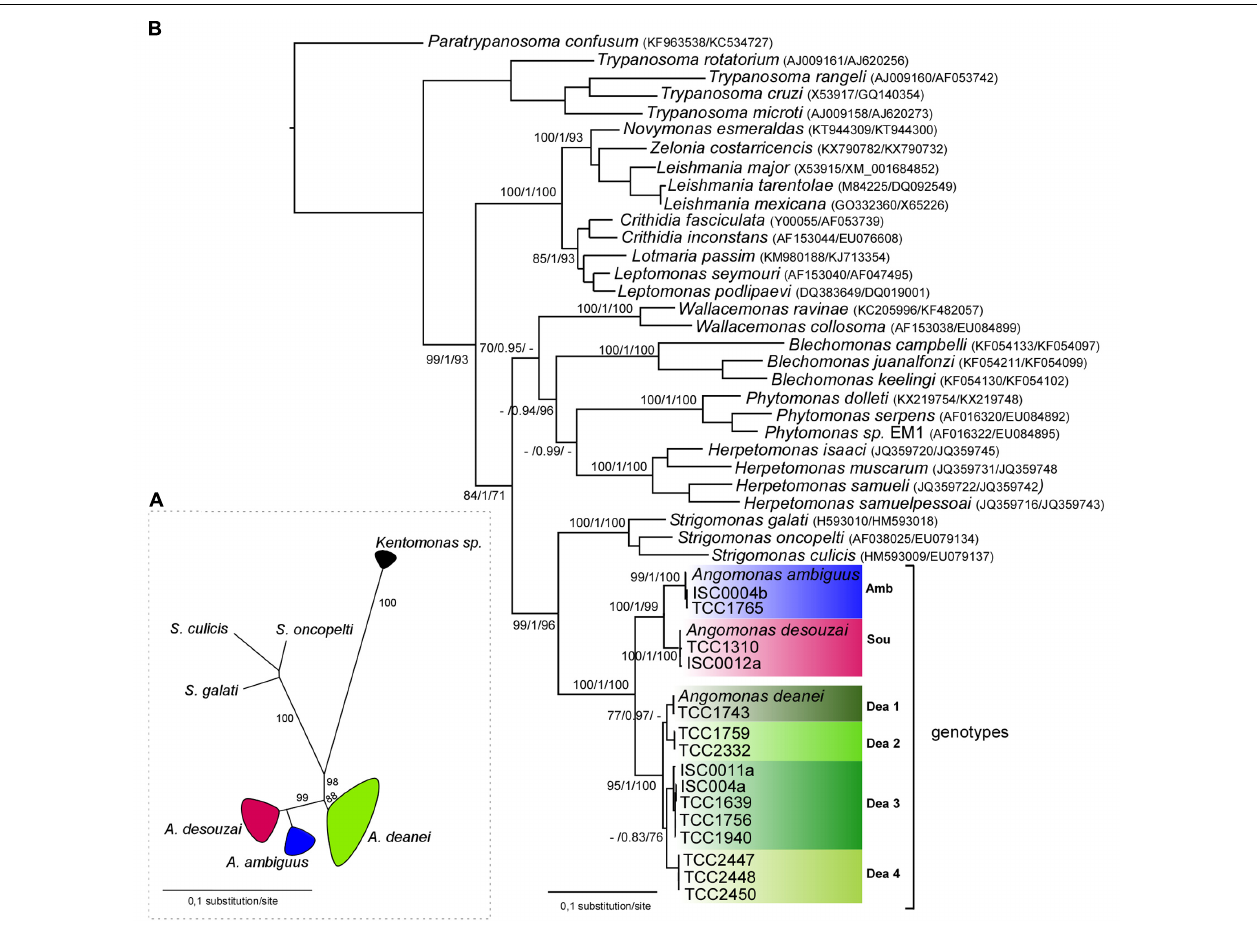
FIGURE 3 | Phylogenetic analysis of Angomonas species and genotypes. (A) Dendrogram (ML) of V7V8 SSU rRNA sequences (barcodes) from 175 (174 from blowflies) cultures of A. deanei ( Dea ), A. desouzai (Amb), and A. ambiguus (Sou), and species of the other genera of symbiont harboring trypanosomatids: Strigomonas culicis , Strigomonas oncopelti, Strigomonas galati, and Kentomonas sorsogonicus. Numbers at the nodes are ML support values ( > 50%) from 500 replicates. (B) Positioning of representatives of each the three Angomonas species and four genotypes of A. deanei (Dea1–Dea4) were showed in the phylogenetic tree of Trypanosomatidae based on concatenated gGAPDH and V7V8 SSU rRNA gene sequences, inferred by maximum likelihood (–Ln = –16564.401081) and Bayesian analyses. Numbers at the nodes correspond, respectively, to ML/BI/P support values ( > 50%) from 500 replicates. GenBank accession numbers of V7V8 SSU rRNA and gGAPDH sequences are shown in Supplementary Table 2.